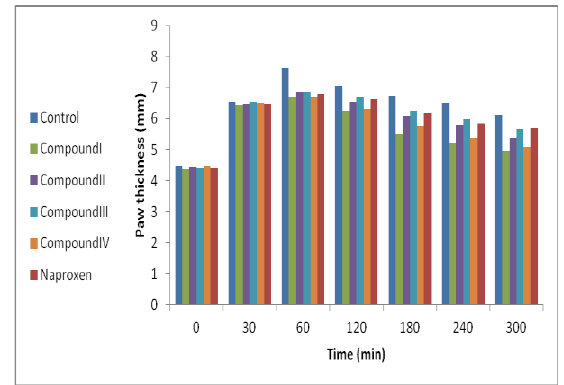
Figure 3: Effect of naproxen, propylene glycol, compounds I, II, III and IV on egg- white induced paw edema in rats. Results are expressed as mean ± SEM (n = 6 for each group). Time (30) is the time of egg-white